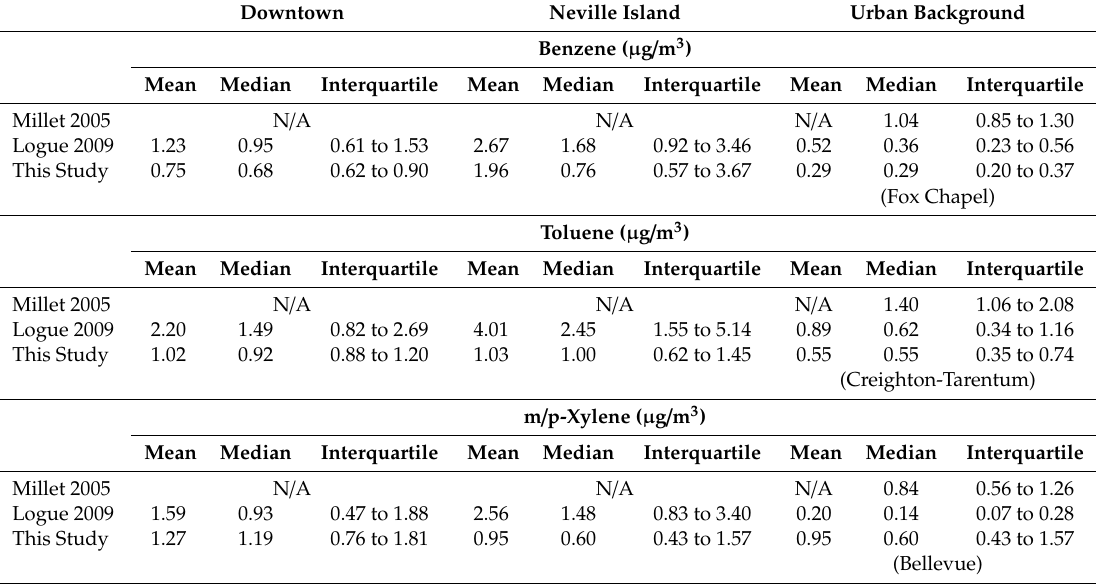
Table 2. Comparison of measurement results with previous studies. Due to the fact that there is no urban background site measurement near CMU campus, we select the site with lowest median concentration (site name noted in parentheses) for comparison to previous